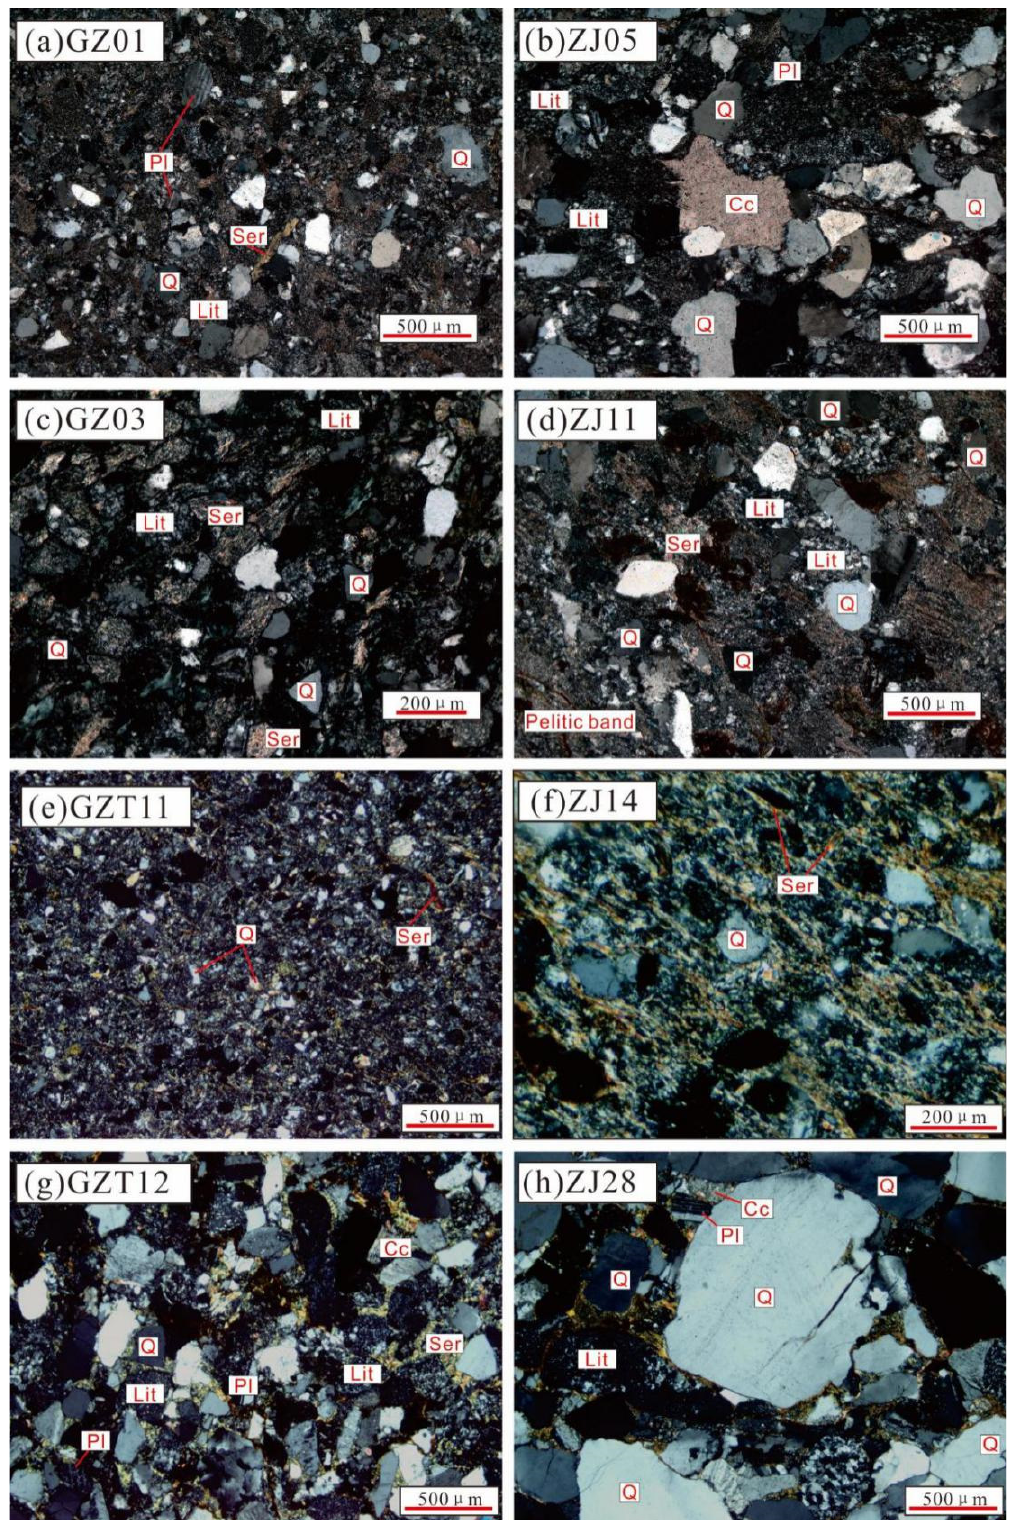
Figure 4. Photomicrographs of samples analyzed in this study. ( a ) Fine-grained lithic sandstone; ( b ) medium-grained feldspathic lithic sandstone; ( c ) fine-grained lithic sandstone; ( d ) medium-grained lithic sandstones; ( e ) fine-grained lithic sandstone; ( f ) silty slate; ( g ) pebbly lithic quartz sandstone; ( h ) sandy conglomerate. Q—quartz; Pl—plagioclase; Ser—sericite; Lit—lithic clast; Cc—calcite.